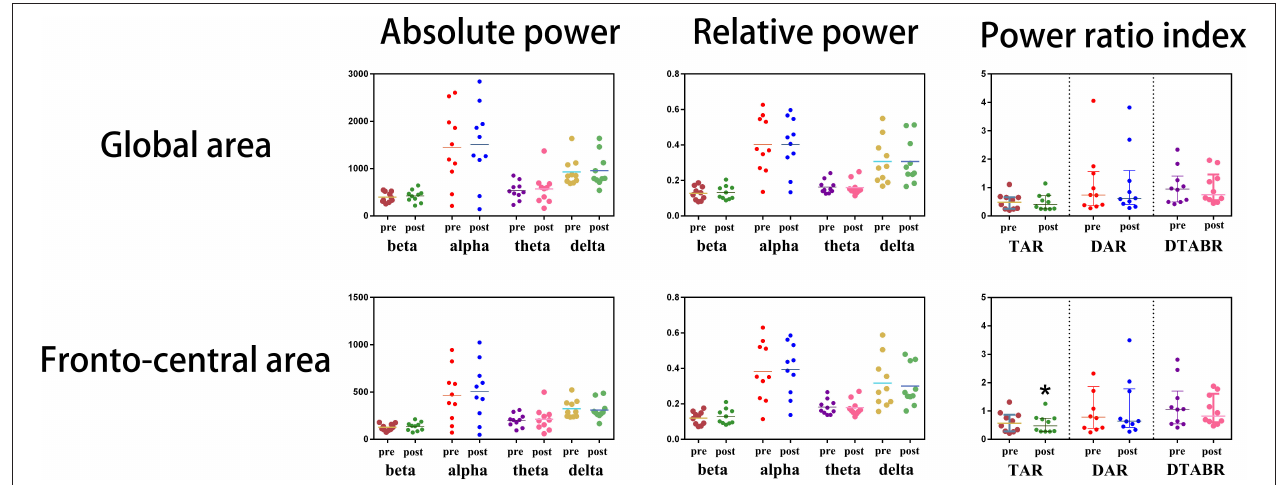
FIGURE 3 | Immediate electroencephalogram (EEG) analysis before and after normobaric oxygen (NBO) intervention.